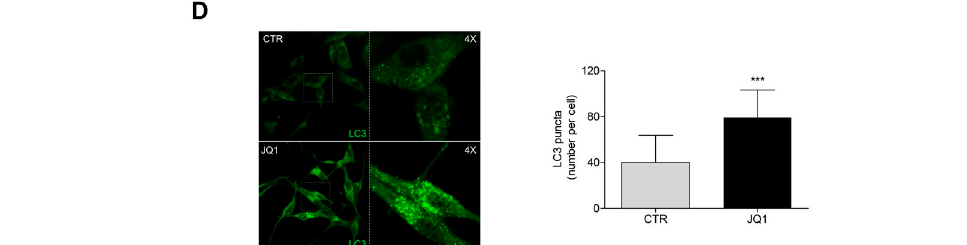
Figure 5. Autophagy is induced in JQ1-stimulated U87 cells. ( A ) U87 cells were cultured in complete DMEM (CTR) or in the presence of 0.5 µ M of JQ1 for 24, 48, and 72 h, and the corresponding protein extracts were analyzed by Western blotting. The protein expression levels and activity of AKT1 and p70S6 were analyzed by using specific antibodies for the phosphorylated and total forms of both proteins. Representative images of three different experiments are shown. VINCULIN was used as a loading control. The corresponding densitometric analyses are shown in the graphs. Statistical signif- icance: ** p < 0.01 and *** p ≤ 0.001, one-way ANOVA. ( B ) Western blotting analysis of the autophagy regulators ULK1, ATG7, ATG5, and BECLIN1 in the protein extracts of the U87 cells stimulated with 0.1 or 0.5 µ M of JQ1 for 24 and 48 h. Representative images of three different experiments are shown. GAPDH was used as a loading control. The corresponding densitometric analyses are shown in the graphs. Statistical significance: *** p ≤ 0.001, one-way ANOVA. ( C ) Autophagy flux was analyzed in the cells stimulated as in (A) in the presence or absence of 20 µ M of chloroquine (CQ). The expression of p62 is shown. VINCULIN was used as a loading control. The corresponding densitometric analyses are shown. Statistical significance: * p < 0.05 and ** p < 0.01, one-way ANOVA. ( D ) U87 cells treated with 0.5 µ M of JQ1 for 48 h and untreated (CTR) cells were subjected to immunocytochemistry and confocal analysis for LC3 (green). Representative images of at least 10 fields showing the merged signals are shown. Scale bar: 30 µ M. A 4 × magnification is shown in the right panel. The LC3 puncta per cell were counted in 30 cells for each condition, and the corresponding graph is shown. Statistical significance: *** p ≤ 0.001, Student’s t